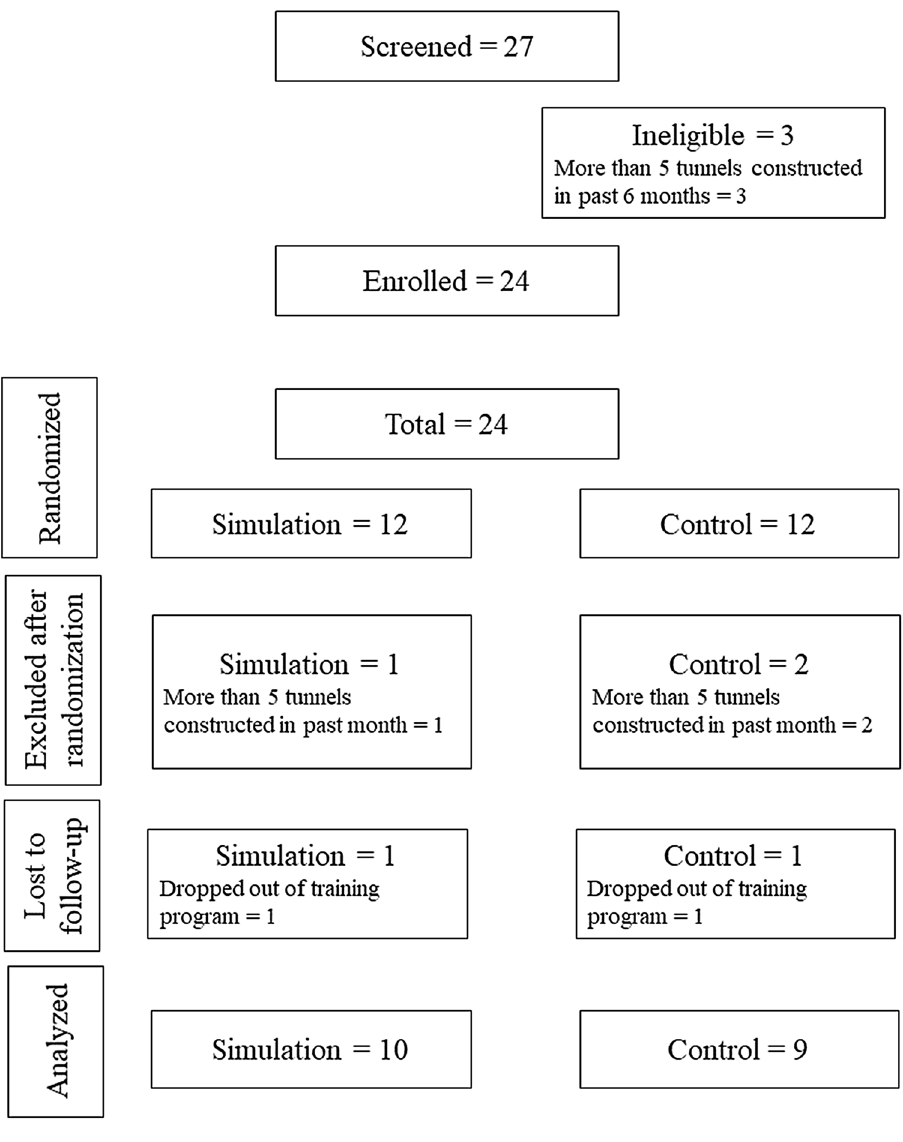
Figure 3. CONSORT flowchart for the